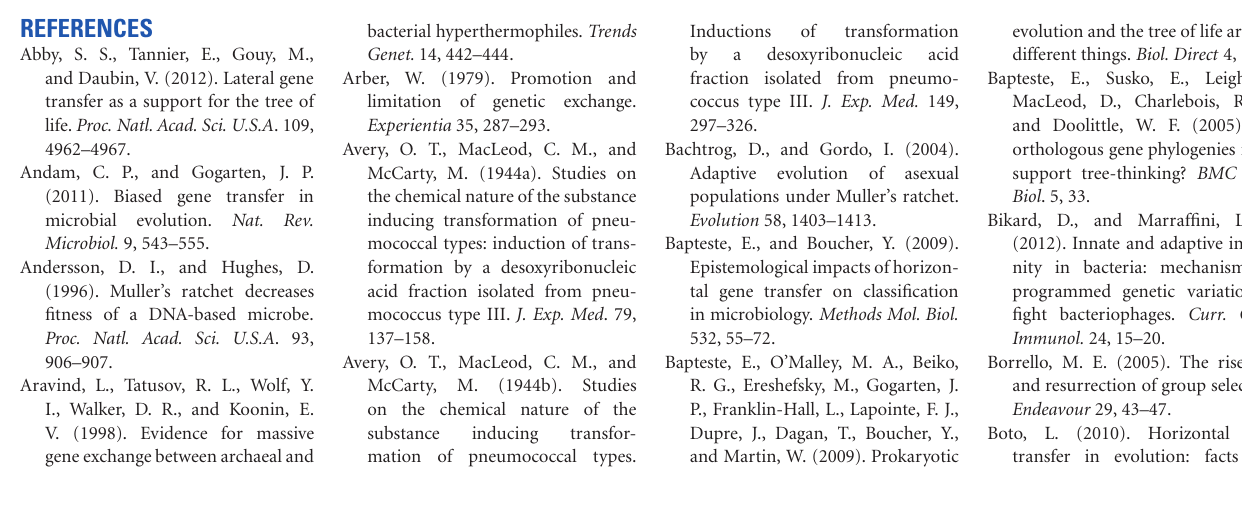
could not be perceived by Darwin or even the creators of the Modern Synthesis due to the lack of relevant data.